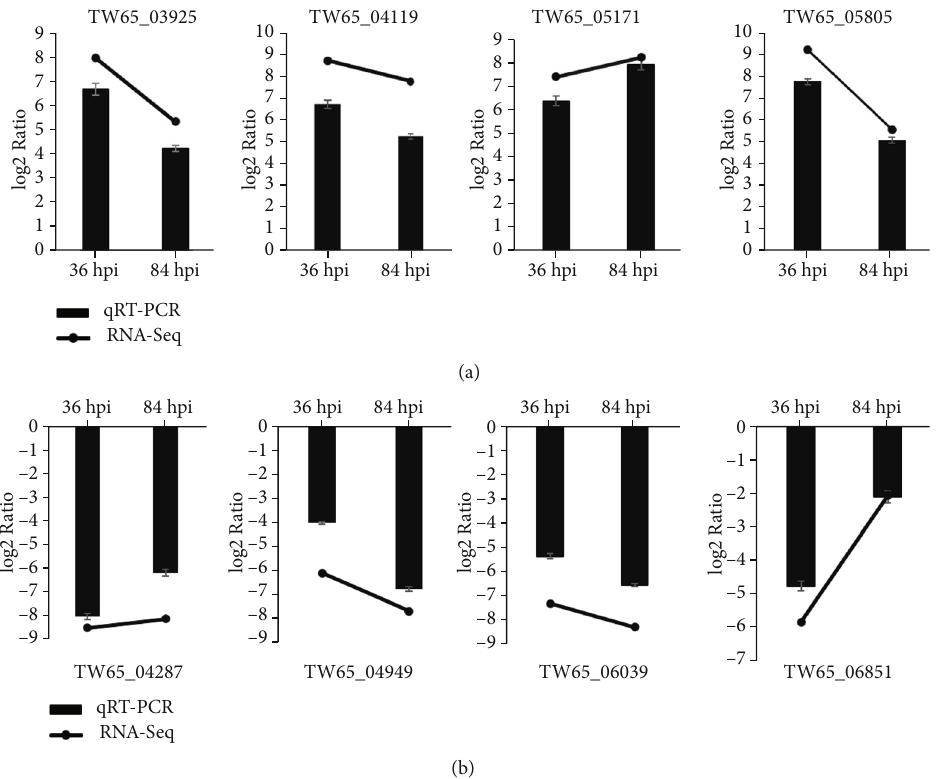
Figure 6: Validation of the expression levels of DEGs in S . lycopersici by qRT-PCR. Relative expression of 4 genes was upregulated (a), while the other 4 genes were downregulated (b) at 36 hpi and 84 hpi.